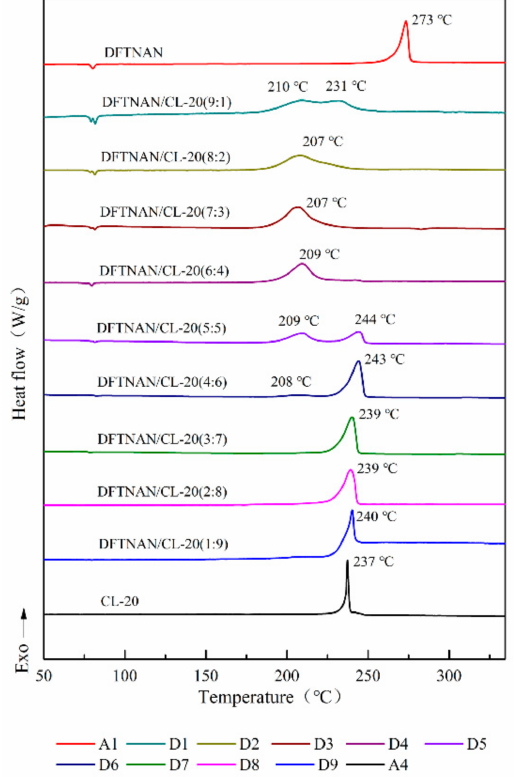
Figure 7. DSC curves of DFTNAN, CL-20 and mixtures with different ratios.